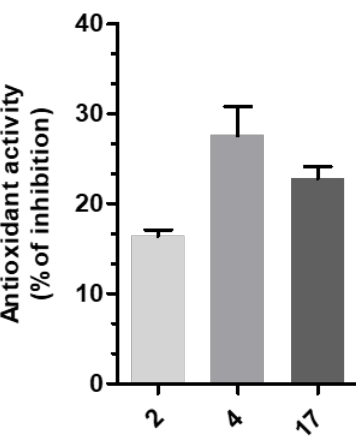
Figure 6. Antioxidant activity of compounds 2, 4 and 17 against the ROS formation induced by t -BuOOH in SH-SY5Y cells. Cells were incubated with compounds 2 , 4 and 17 (1.25 µ M) for 24 h and then treated with t -BuOOH (100 µ M) for 30 min. At the end of incubation, intracellular ROS formation was detected using the fluorescent probe H 2 DCF-DA, as described in the Materials and Methods section. Data are expressed as antioxidant activity in terms of inhibition percentage in ROS formation induced by t -BuOOH and are reported as mean ± SEM of three independent experiments.